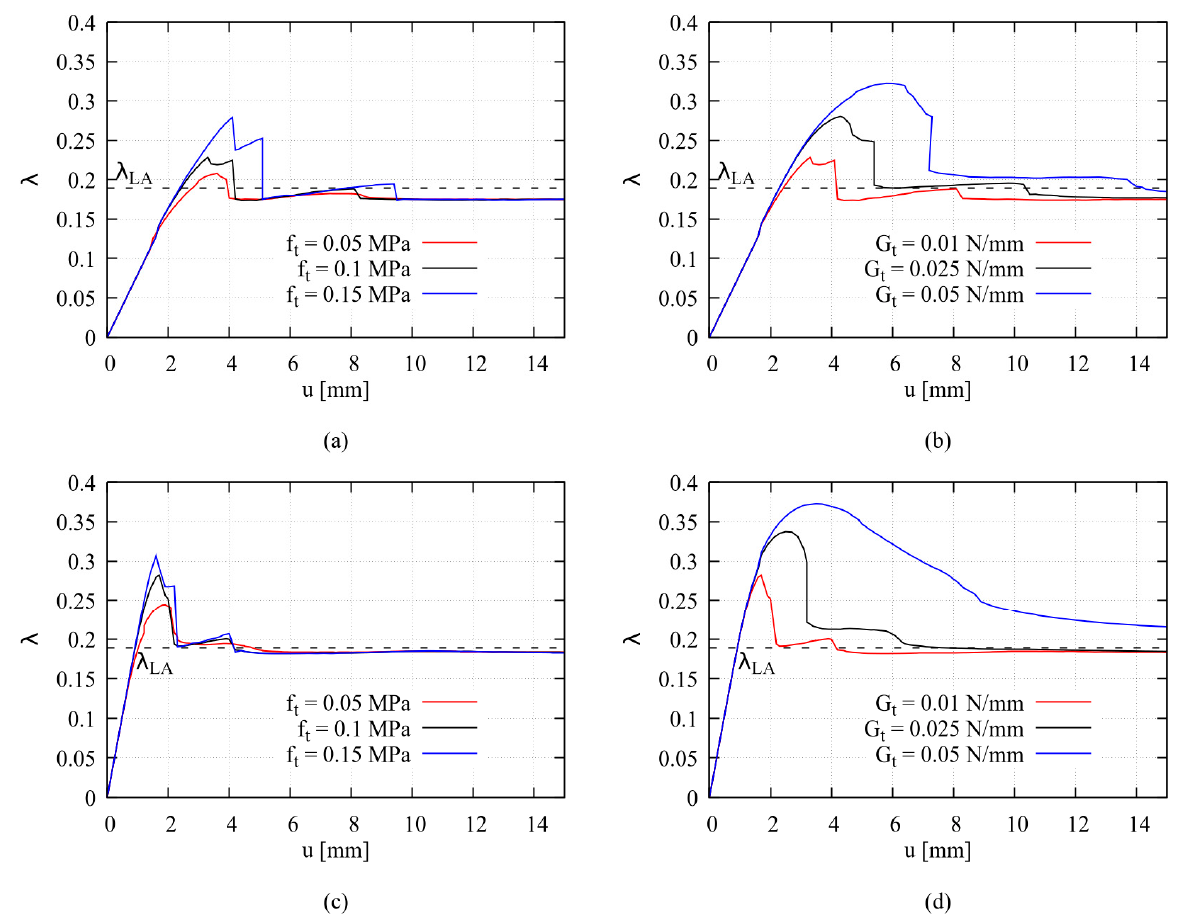
Figure 10. λ - u plots for the analysed models: ( a , b ) weak masonry, ( c , d ) strong masonry. ( a , c ) plots at varying f t , ( b , d ) at varying G t .